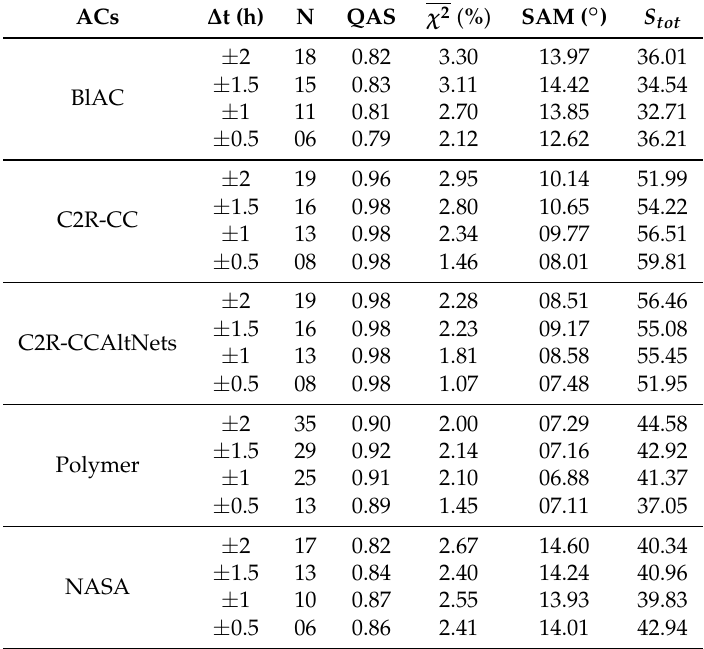
Figure 4. Spectral variation of the statistical parameters between 440 and 750 nm: α (top-left), β (top-middle), bias (top-right), RE (bottom-left), RMSE (bottom-middle), and R 2 (bottom-right). The color code is similar to Figure 3 and given in the text box of the top middle subplot in addition to the match-up numbers. Table 2. Values of QAS, χ 2 , SAM and S tot associated with different time windows. N is the number of match-ups and ∆ t is the time window. SAM, spectral angle